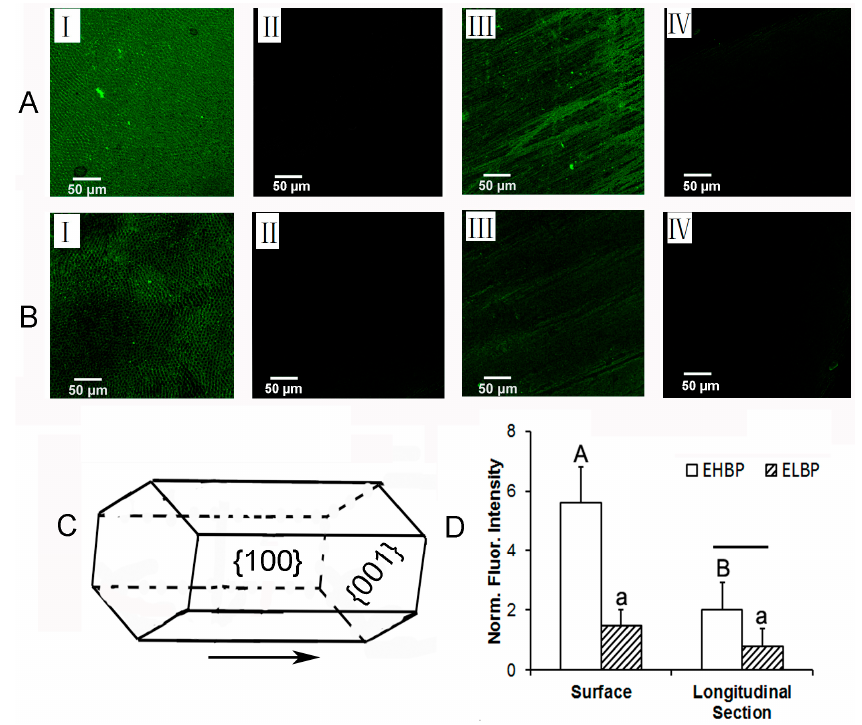
Figure 2. CLSM observation of FITC-labeled EHBP binding to enamel surface ( A-I ), and longitudinal section ( A-III ), as well as FITC-labeled ELBP binding to enamel surface ( B-I ) and longitudinal section ( B-III ). Fluoresce intensity of FITC without EHBP or ELBP as conjugates on the same enamel surface ( A-II , B-II ) or the longitudinal section ( A-IV , B-IV ) was served as control to normalize respective fluoresce intensity. Crystal {001} and {100} faces are illustrated in ( C ). For each parameter (upper case letters for EHBP and lower case letters for ELBP) in ( D ), groups with the same letters are not statistically significant ( p > 0.05). For comparisons between EHBP and ELBP, groups connected with a bar are not statistically significant ( p > 0.05).